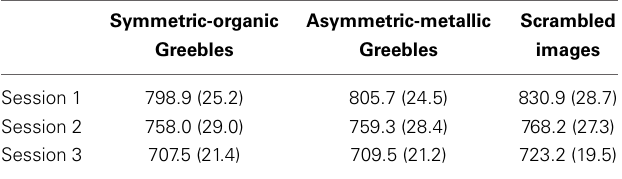
Table 2 | Mean response times (ms) in the word judgment task for each image type (Symmetric-organic Greebles, Asymmetric-metallic Greebles, and scrambled images) across the three testing